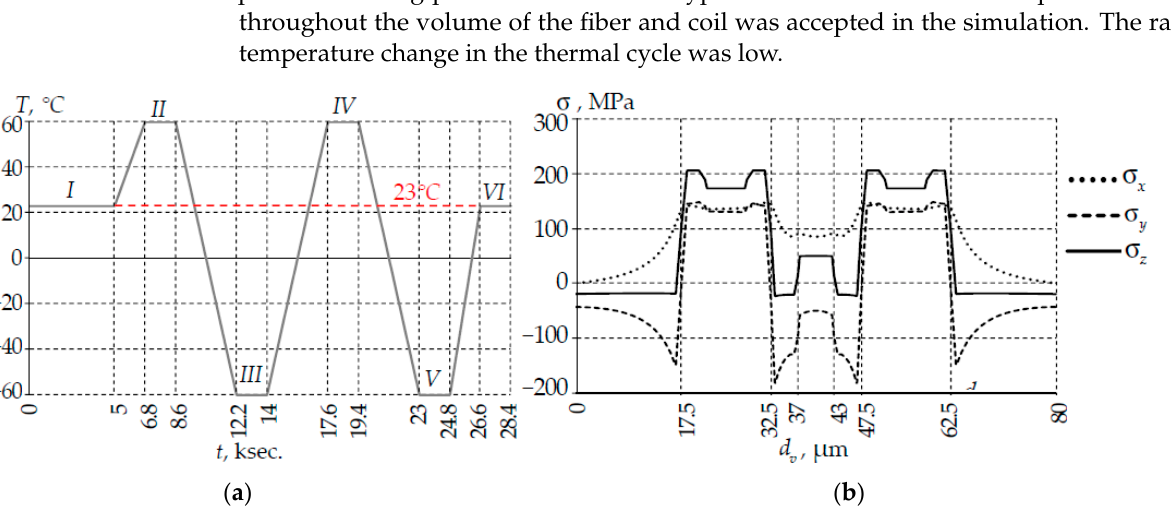
Figure 3. Temperature cycle ( a ) and diagrams of residual stresses along the fiber central section after drawing and polarization ( b ): I–VI are numbers of holding zone at constant temperature; I is 23 °C; II is 60 °C; III is − 60 °C; IV is 60 °C; V is − 60 °C; VI is 23 °C.